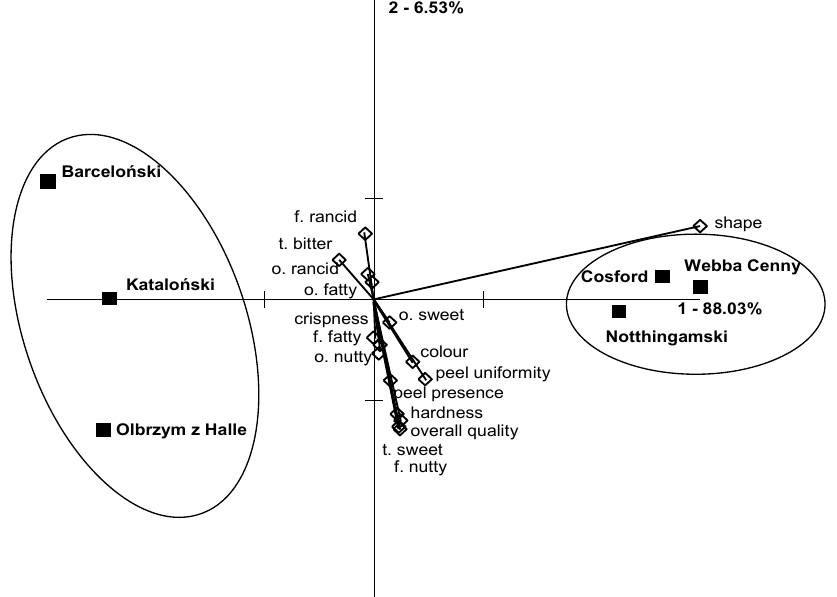
Figure 1. Principal component analysis plot of the similarities and differences in the sensory profiling characteristics of the nuts (o. is odour, f. is flavour, t. is taste).